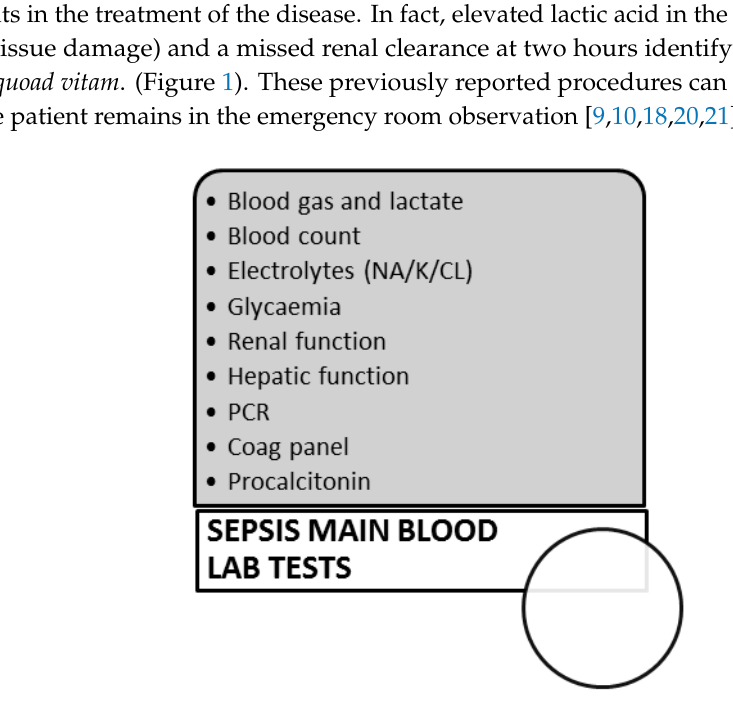
Figure 1. Panel of the blood investigations.